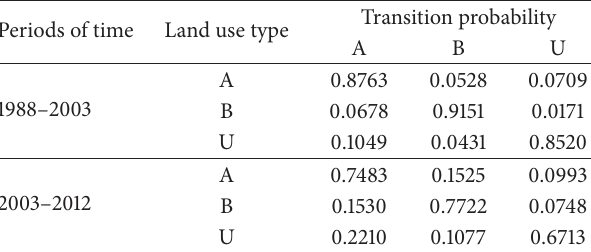
Table 4: Transition probability matrix. Periods of time